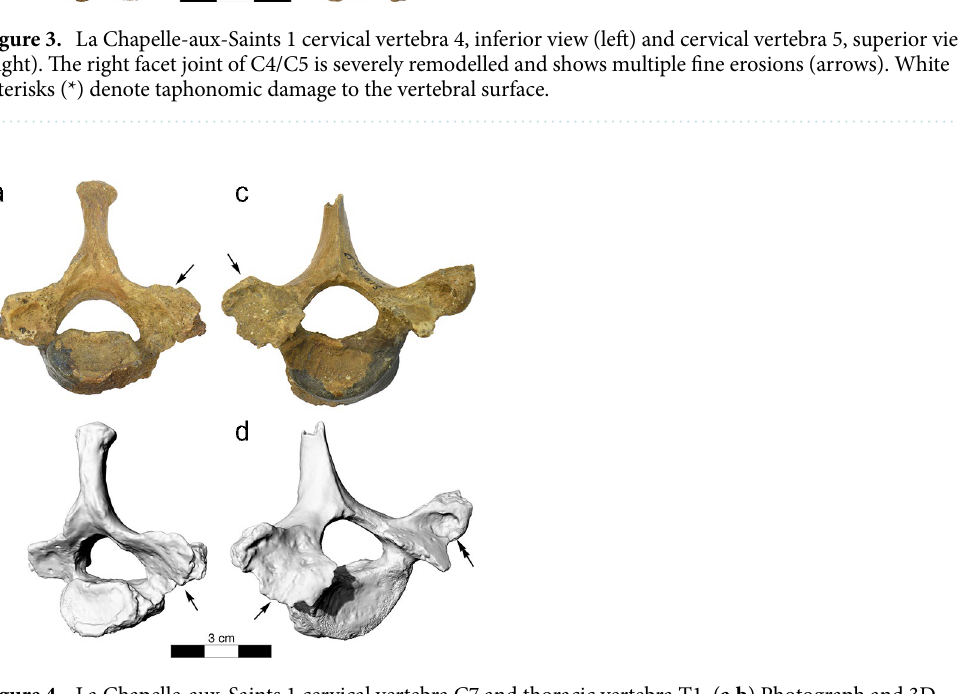
Figure 4. La Chapelle-aux-Saints 1 cervical vertebra C7 and thoracic vertebra T1. ( a , b ) Photograph and 3D surface scan of C7, inferior view, ( c , d ) photograph and 3D surface scan of T1, superior view. The right facet joint of C7/T1 is severely remodelled and shows multiple fine erosions (arrows). The transverse process of T1 shows a large erosive defect suggestive of a space-occupying granulomatous process (double